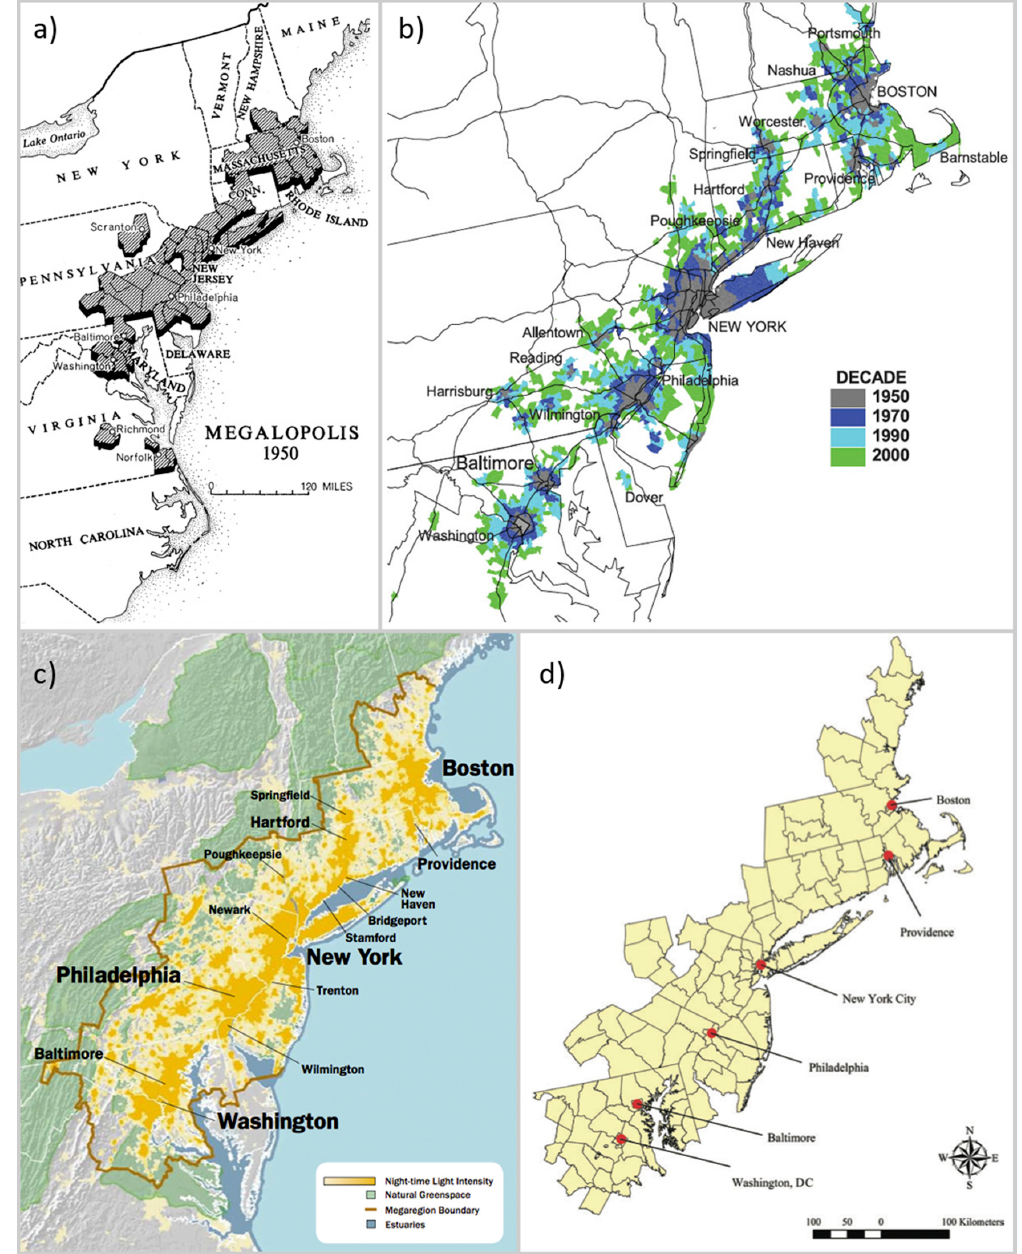
Figure 2. Maps of Megalopolis. ( a ) Gottmann, 1957; ( b ) Morrill, 2006; ( c ) Regional Plan Association, 2007; ( d ) Vicino, Hanlon and Short, 2007. Table 3. Growth of Megalopolis 1950–2010 (after Morrill, 2006,